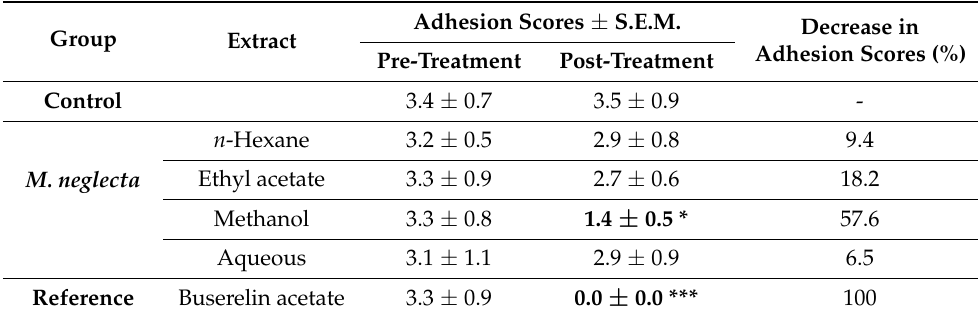
Table 2. Intra-abdominal adhesion scores of extracts prepared from the leaves of M. neglecta on endometriotic implants in rats.